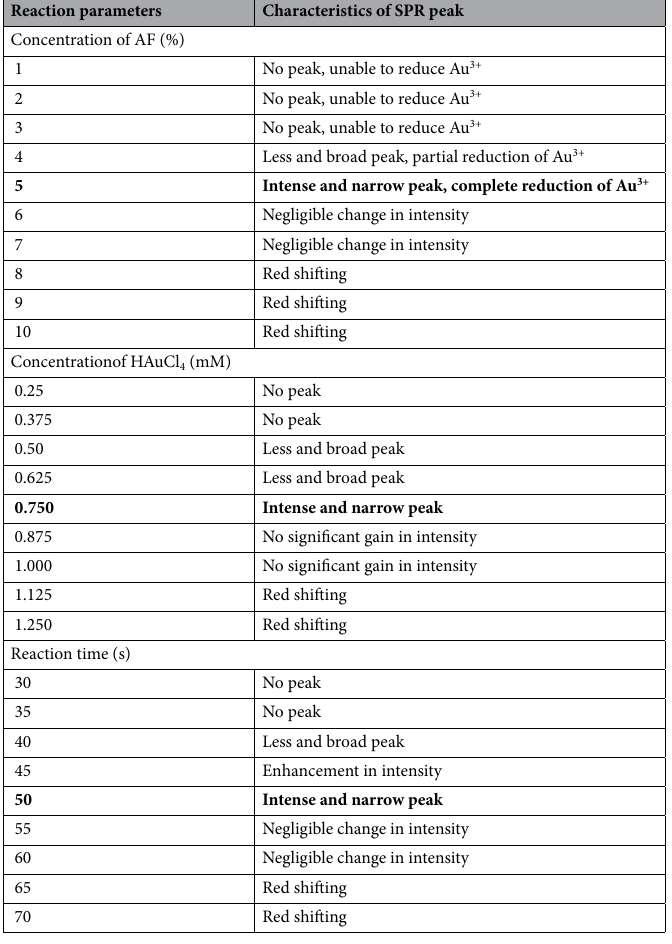
Table 1. Optimization of reaction parameters for the synthesis of prism shaped nanozymes. The optimized reaction parameters are in [bold].